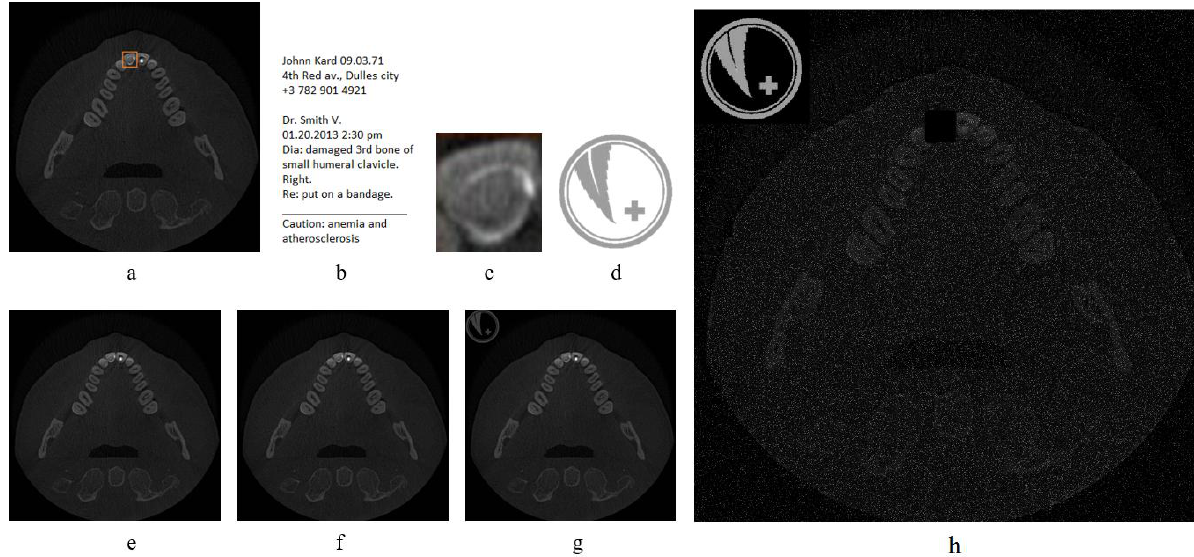
Figure 3. Initial data and visual examples of watermarking process: a original slice for embedding, b textual watermark, c ROI watermark (increased in 3 times), d fragile watermark, e watermarked slice after embedding of ROI watermark, f watermarked slice after embedding of ROI and textual watermarks, g watermarked slice after embedding of ROI, textual, and fragile watermarks, h increased difference map between original and watermarked images